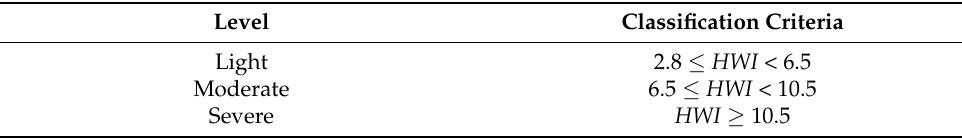
Table 1. Criteria for classifying heatwave